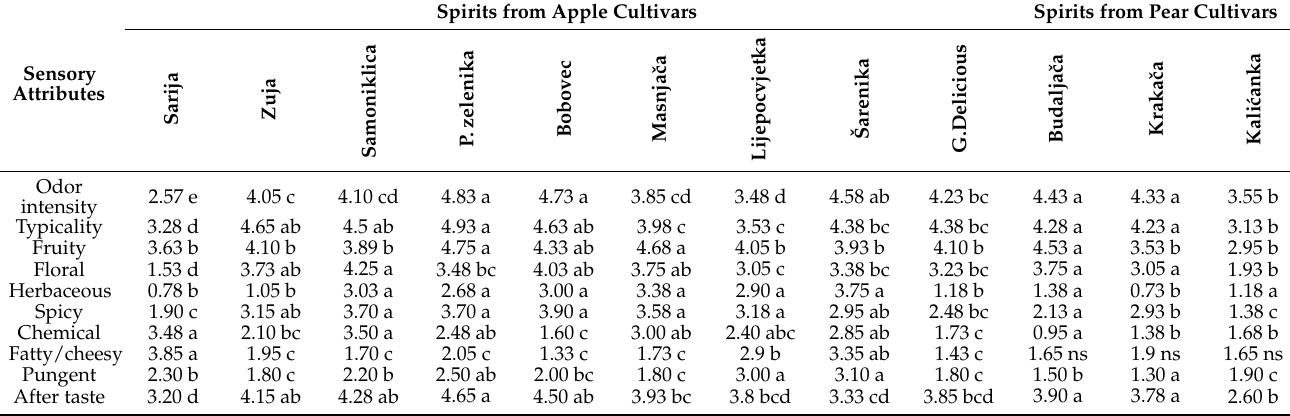
Table 3. Results of sensory evaluations of the spirits obtained from old apple and pear cultivars in B&H. Spirits from Apple Cultivars Spirits from Pear Sensory Attributes